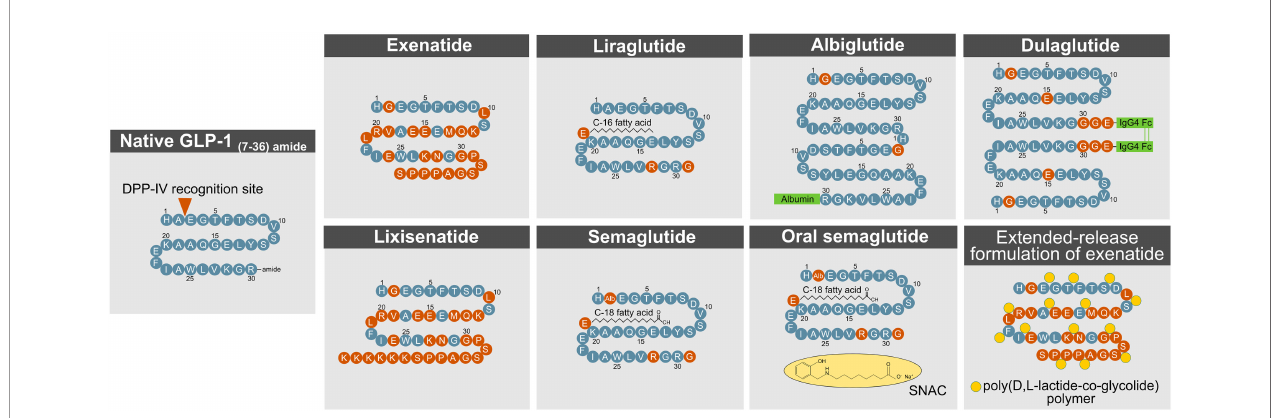
FIGURE 4 | Methods to enhance GLP- 1R action. DPP- 4, dipeptidylpeptidase-4; GLP- 1,